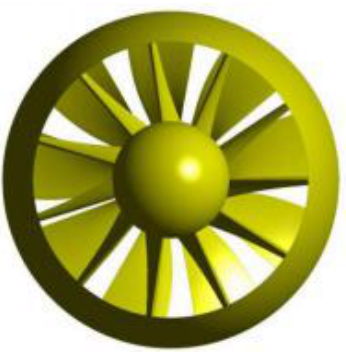
Figure 9. Pump-jet propulsion model designed by the inverse method.